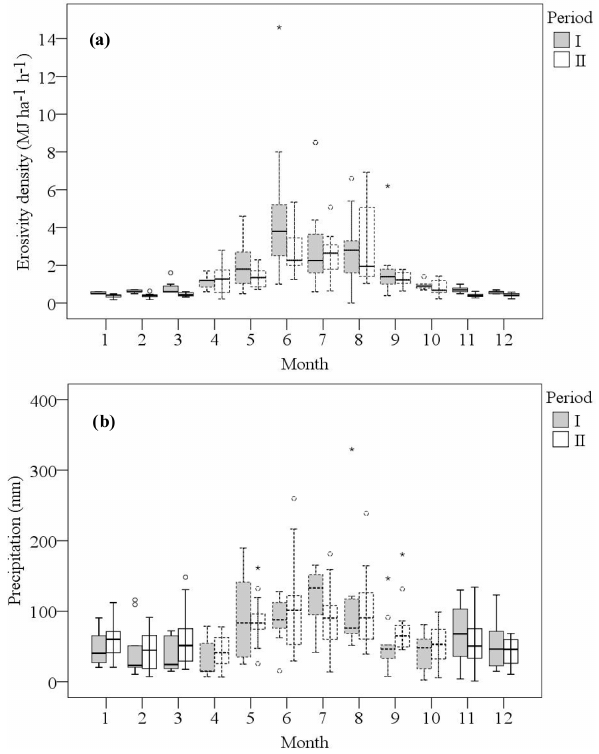
Figure 3. Monthly erosivity density (a) and monthly precipitation (b) for periods I and II. The bars with a dashed outline represent the growing seasons (April–October), the bars with a solid outline de- note the dormant seasons (November–March), the whiskers indicate the range between the minium and the maximum, and the asterisks indicate the